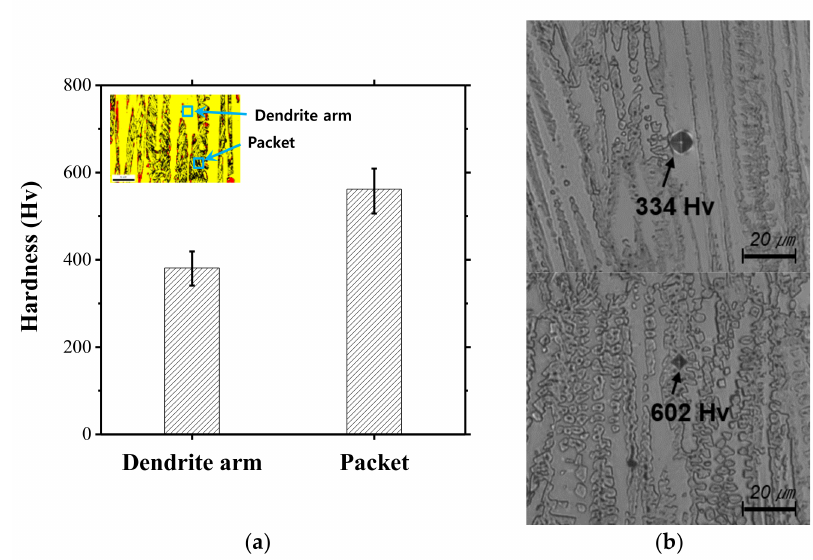
Figure 7. Local Vickers hardness in fusion zone of laser welds formed using a laser power of 3 kW and a welding speed of 8 m/min at a 0 mm focal position using a 450-mm focusing optic system: ( a ) the hardness of the dendrite arm and dendrite arm spacing region and ( b ) optical images of measurement